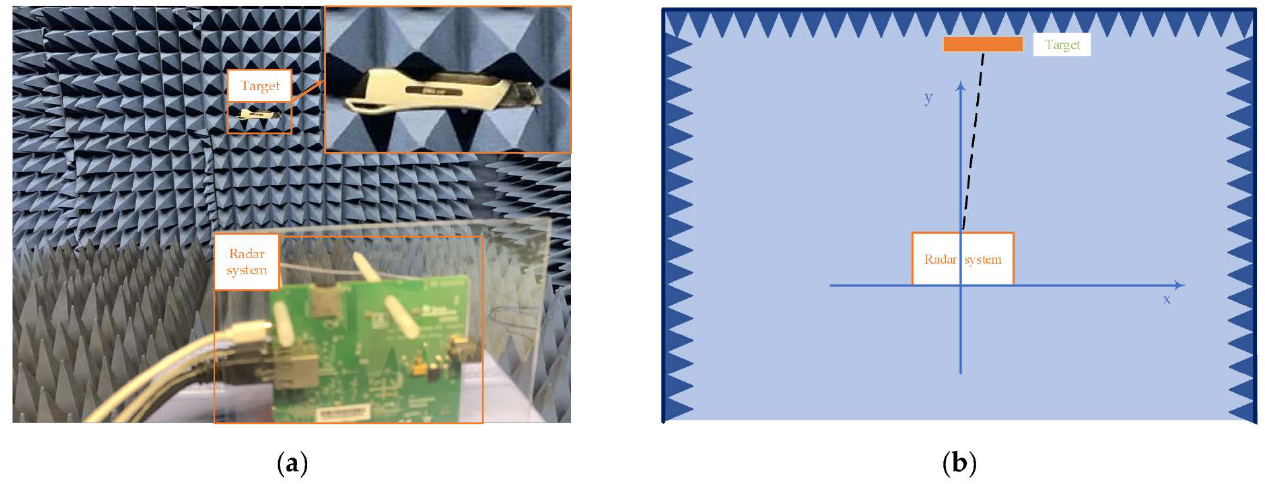
Figure 13. The experimental scene diagram. ( a ) is the experimental scene. ( b ) is the model diagram of